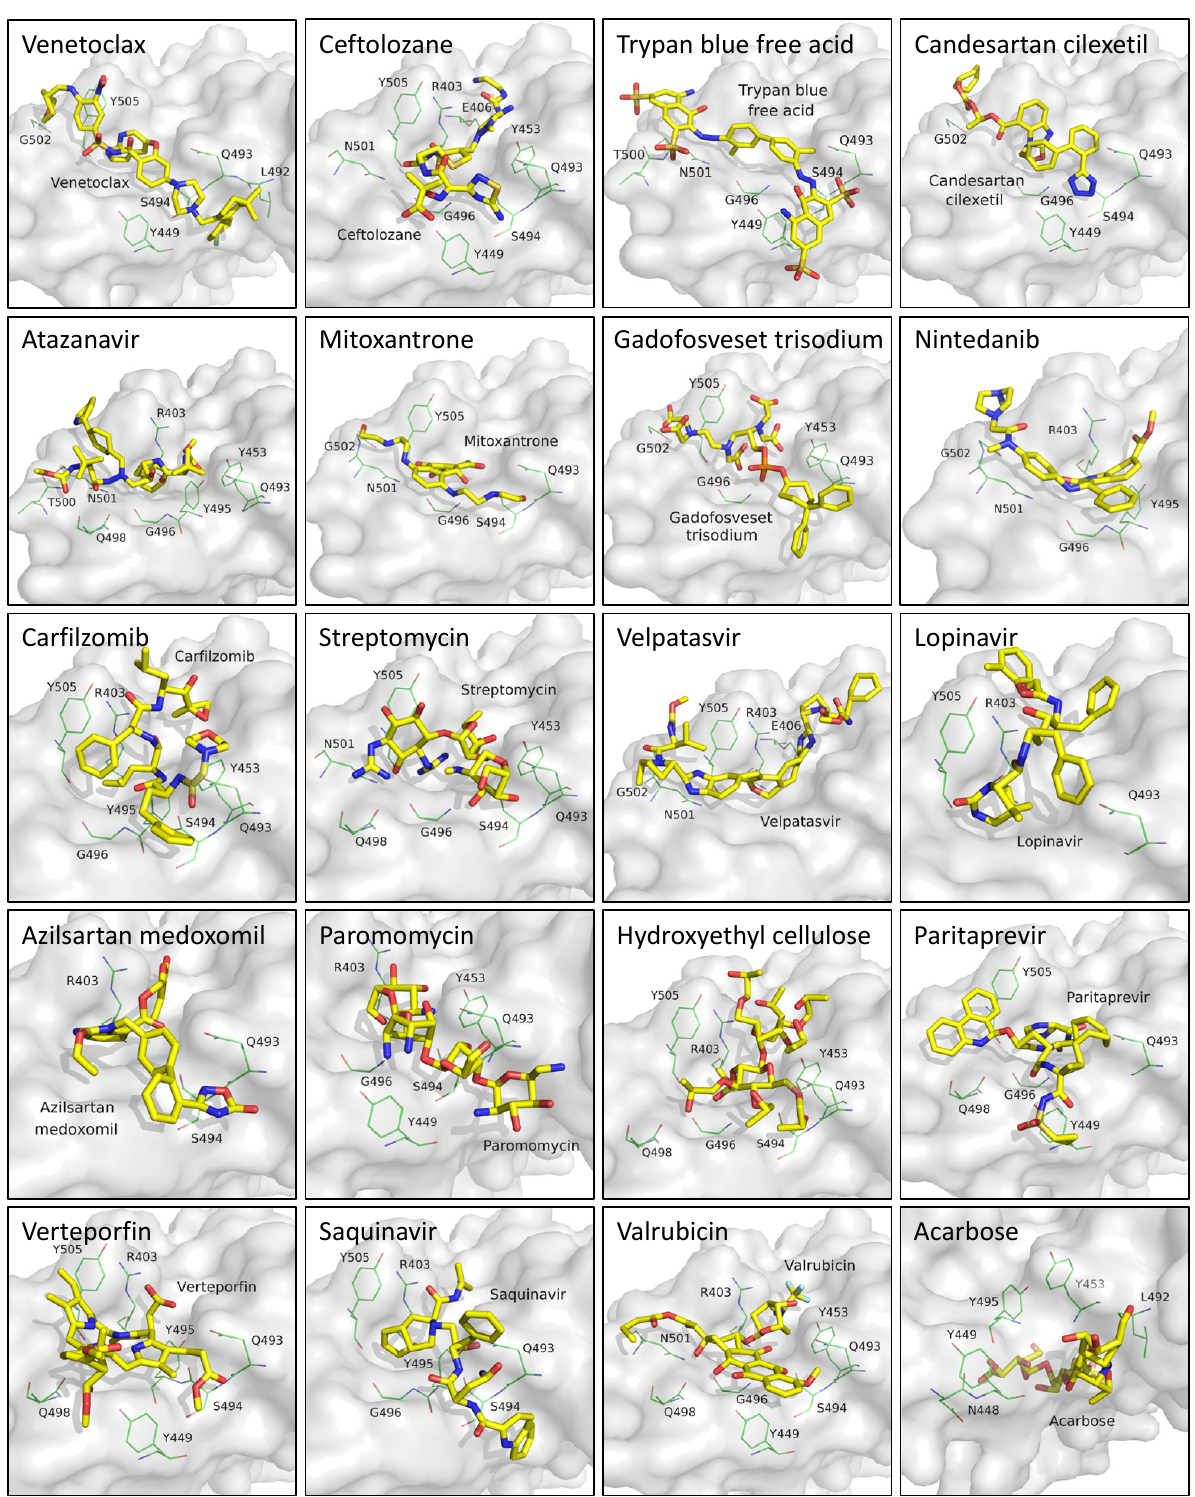
Figure 3. Molecular docking of the top 20 candidates with the best docking scores. The interacting residues are labeled.